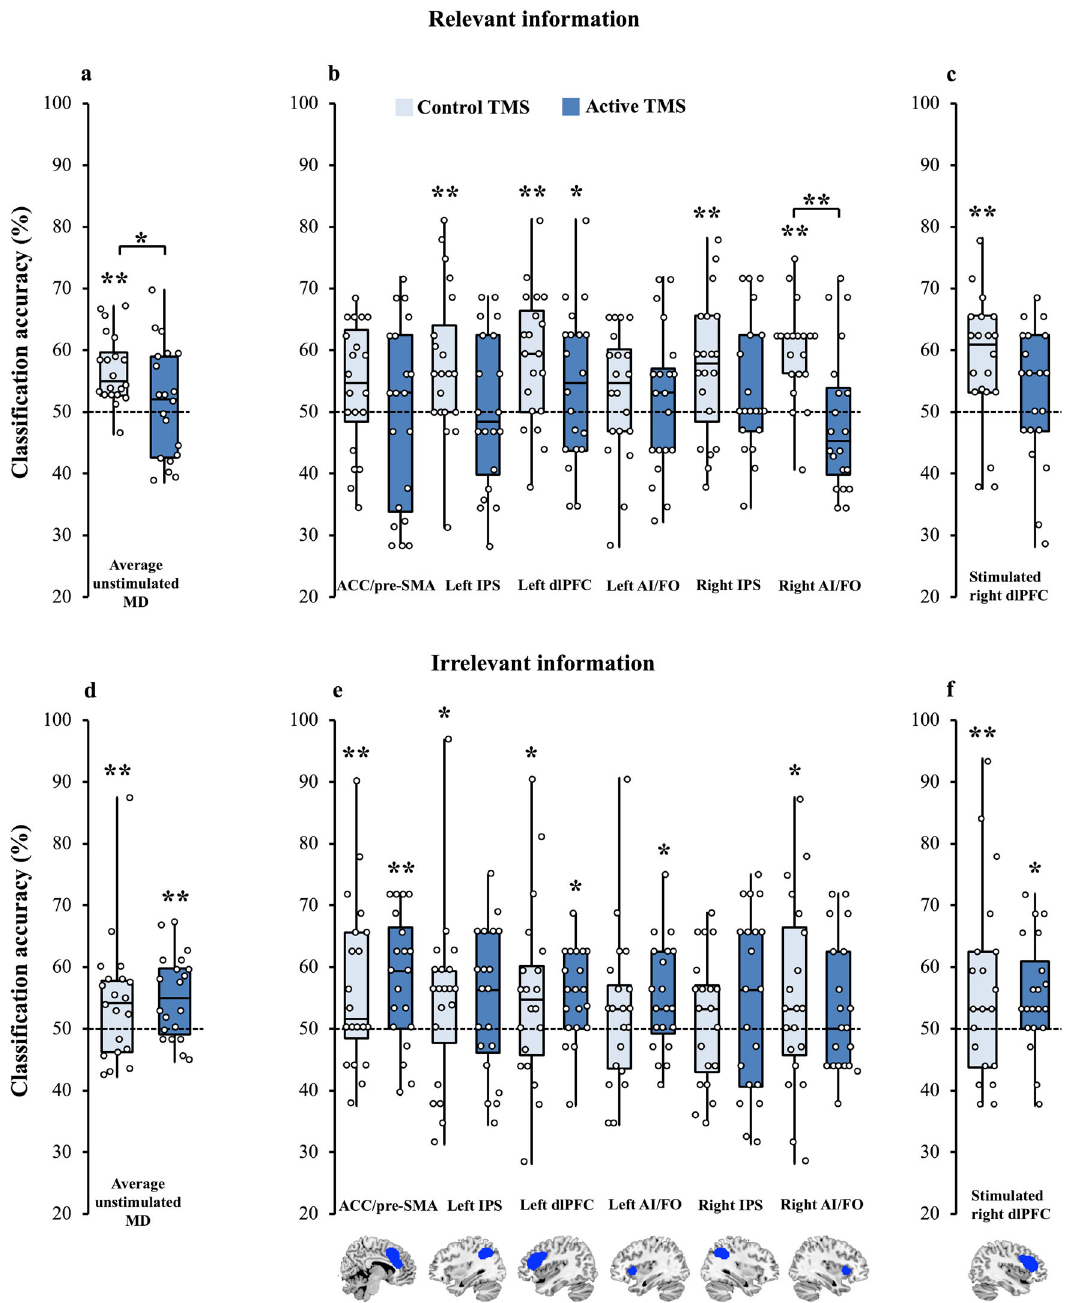
Fig. 5 Coding of relevant and irrelevant information in MD regions under Control and Active TMS conditions. Box plot summary depicting minimum and maximum values, lower and upper quartiles and median scores. Individual data points indicated by open circles. Lighter-coloured bars depict coding under control TMS, and darker-coloured bars depict coding under Active TMS trials. a – c show coding of relevant information (e.g., colour during the colour task) under Control and Active conditions, collapsed across feature (colour, form). d – f show coding of irrelevant information (e.g., colour during the form task) under Control and Active conditions, also collapsed across feature. All bars represent coding of identical stimulus information, variation in the strength of coding is driven by TMS intensity and whether the information was relevant for the participant ’ s current task. Due to outliers (>3 SD from the condition mean), we performed a log transformation on the unstimulated MD region data before statistical testing. The data displayed are in the untransformed form prior to log transformation. An ANOVA on the unstimulated MD regions ( a , d ) showed a signi fi cant TMS × relevancy interaction. TMS reduced coding of relevant features in unstimulated MD regions, but did not modulate coding of irrelevant information (BF 10 = 0.24). The ANOVA for right dlPFC (factors: TMS, Feature and Relevancy; c , f ) showed no signi fi cant main effects or interactions. The signi fi cance markings for individual bars indicate whether coding was signi fi cantly greater than chance in each condition separately (permutation test). * P < 0.05. In this fi gure only, ** is equal to P < 0.008 (to correct for multiple comparisons in 6 unstimulated MD regions). N = 20